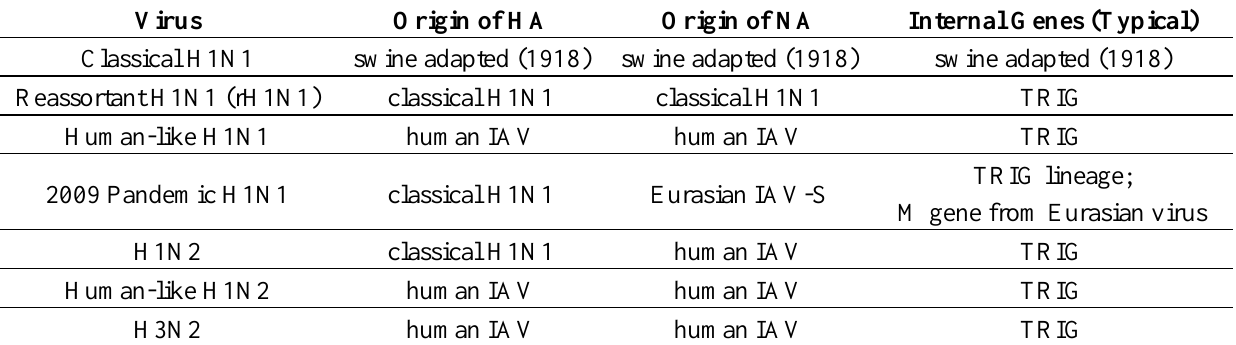
Table 2. Major IAV-S lineages that have been found among pigs in North